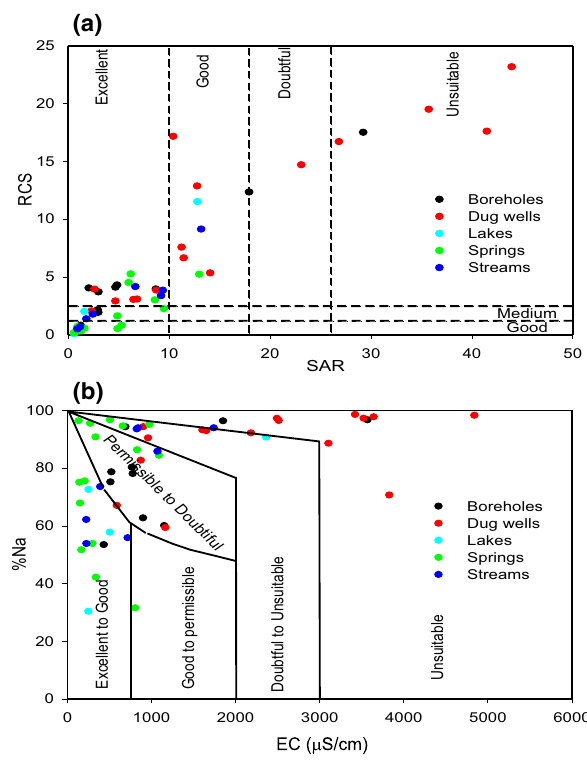
Fig. 21 Classification of Meru water types for irrigation pur- poses (After Wilcox 1955). a Classification based on RCS and SAR with exception of Lake small Momella with RCS = 80.65 and SAR = 60.15. b Classification based on percent sodium and electrical conductivity with exception of Lake small Momella with EC = 8715 and %Na = 99.06